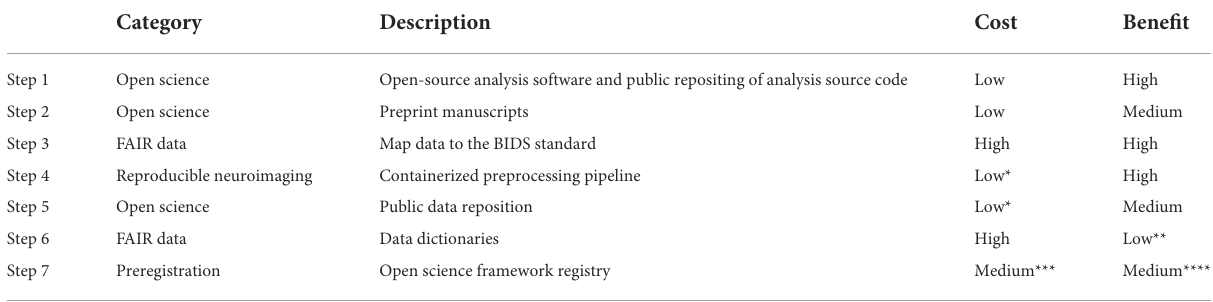
TABLE 1 Summary of open and reproducible neuroimaging transition costs-benefits